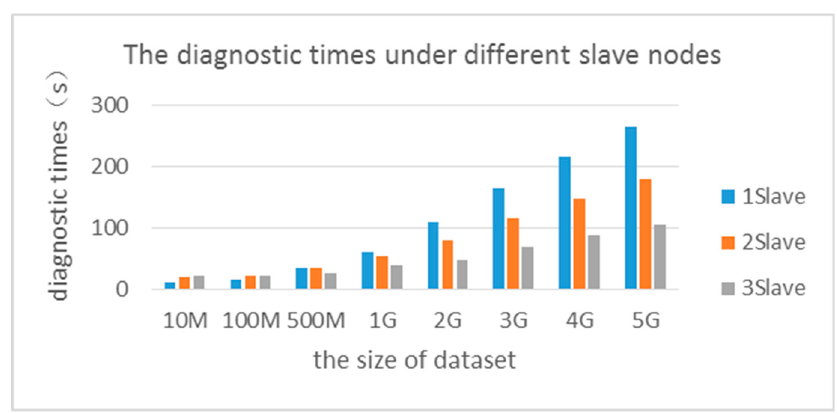
Figure 13. The diagnostic times under different slave nodes. Table 13. The speedup of fault diagnosis under different node numbers.